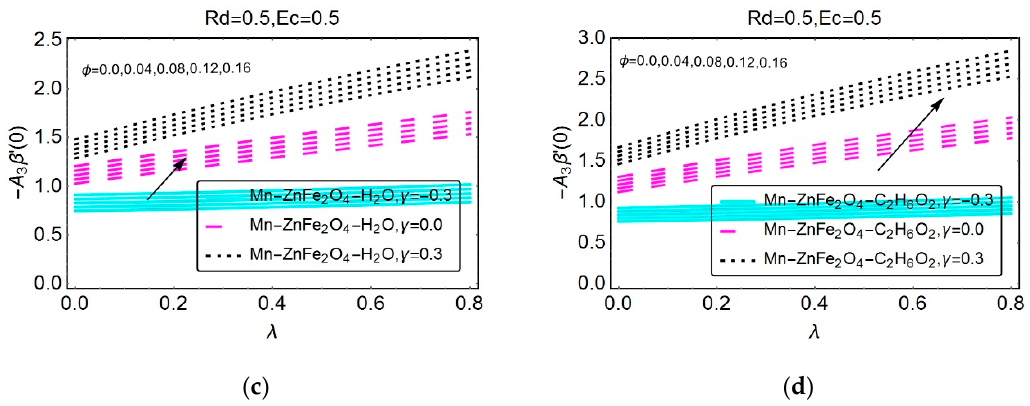
Figure 11. Alterations in the local nusselt number for ( a ) CoFe 2 O 4 − H 2 O; ( b ) CoFe 2 O 4 − C 2 H 6 O 2 ; ( c ) MnZnFe 2 O 4 − H 2 O; ( d ) MnZnFe 2 O 4 − C 2 H 6 O 2 nanofluids by varying φ and λ .